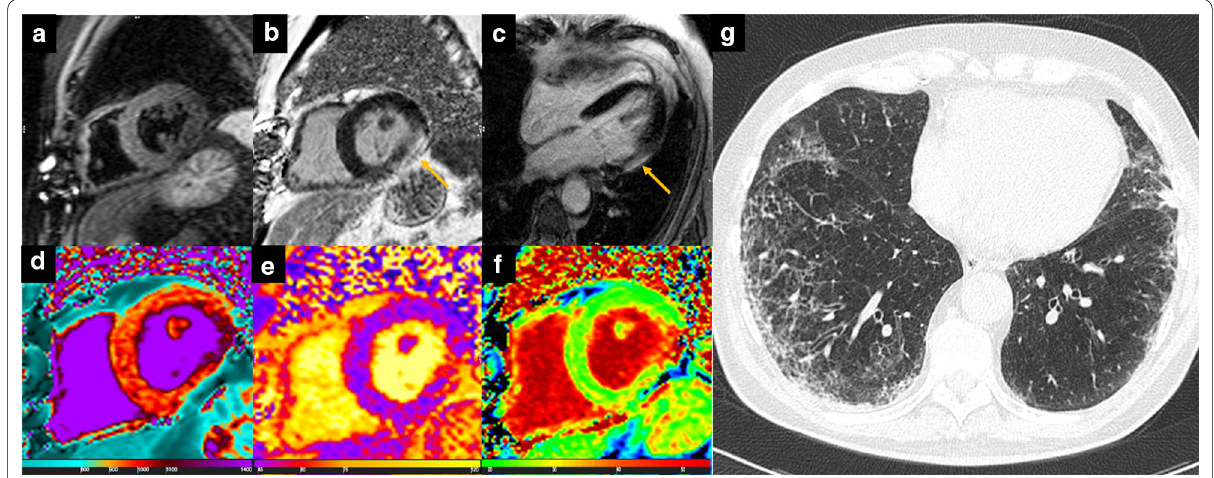
Fig. 2 Myocarditis. 51-year-old man hospitalized for COVID ‐ 19 pneumonia and sudden onset of tachyarrhythmias. STIR images revealed no edema ( a ), although LGE was evident on infero-lateral segments of basal-mid planes with a subepicardial pattern of distribution ( b , c orange arrows) and native T1 was increased on LGE segments ( d ). T2 mapping sequences revealed the presence of edema on infero-lateral segments of + mid-ventricular planes ( e ). ECV confirmed those findings with implemented values on infero-lateral wall ( f ). Chest CT showed GGO predominantly distributed on inferior lobes with a peripheral distribution ( g ). STIR short tau inversion recovery, LGE late gadolinium enhancement, ECV extracellular volume, CT computed tomography, GGO ground glass